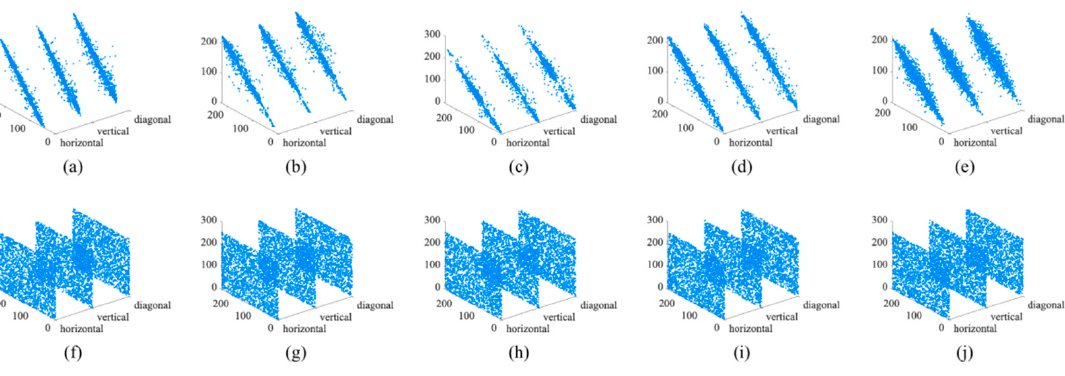
Figure 11. ( a – e ) Correlation plot of Lena, Airplane, Cameraman, Pepper, and Baboon. ( f – j ) Corre- lation plot of encrypted images of Lena, Airplane, Cameraman, Pepper, and Baboon. Table 3. Results of correlations of adjacent pixels.